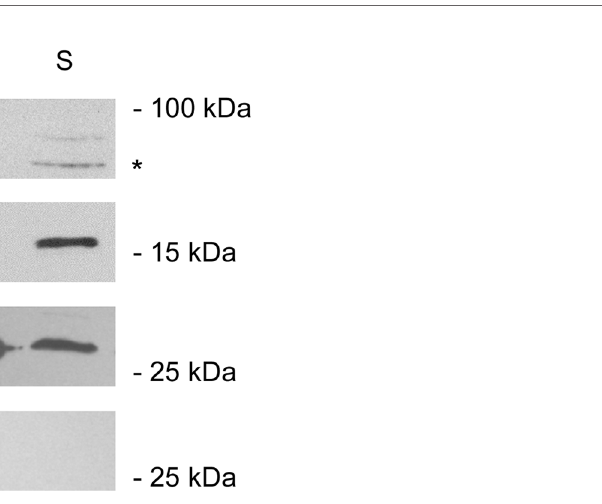
FIGURE 2 | Cyclophilin inhibition blocks PTS1 translocation to the cytosol. CHO cells were mock transfected or transfected with an expression plasmid that directs PTS1 for co-translational insertion into the ER. The toxin is then dislocated from the ER into the cytosol. At 24 h post-transfection, permeabilization of the plasma membrane with digitonin was used in conjunction with differential centrifugation to separate cell extracts into two fractions: a pellet (P) containing intact organelles and a supernatant (S) containing the cytosol. Both fractions from mock-transfected cells were probed by Western blot with antibodies against the lumenal ER protein GRP94 or the cytosolic protein cyclophilin A (CypA). Fractions from PTS1-expressing cells incubated in the absence or presence of cyclophilin inhibitor CsA were probed by Western blot with an antibody against PTS1. The asterisk denotes a non-speci fi c band, most likely due to the secondary antibody, also detected in the cropped region of the CypA and PTS1 blots. One of three representative results is shown.